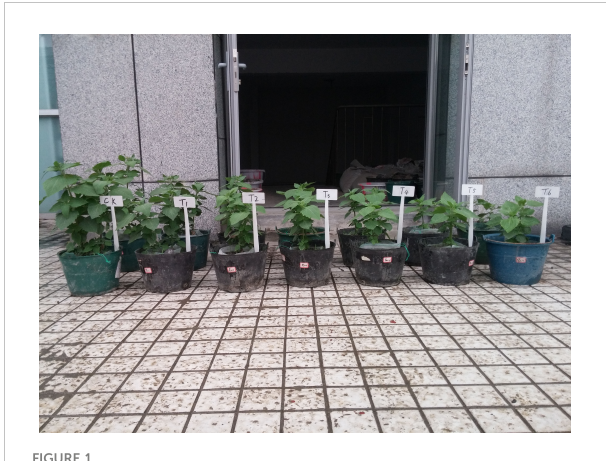
FIGURE 1 The growth of S. orientalis in potted plants under Cd stress.